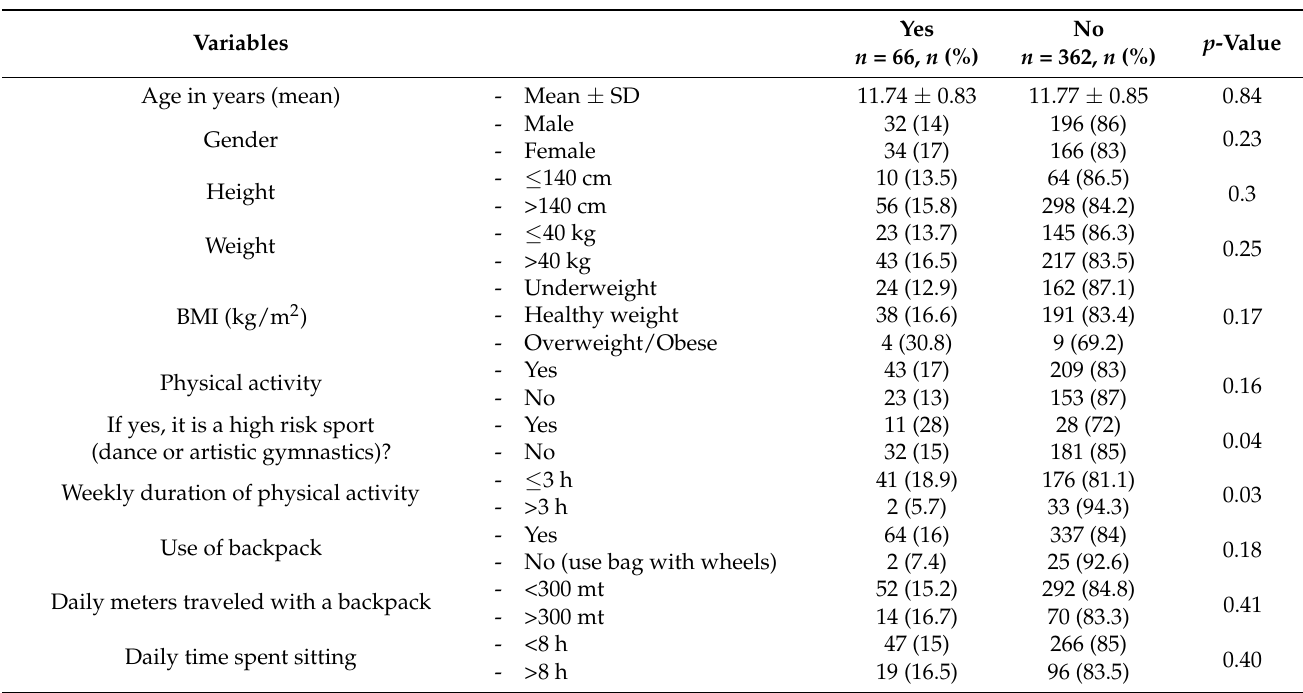
Table 1. Sociodemographic characteristics and daily personal habits of pre-adolescents enrolled in the first-grade secondary schools of the Palermo district of the study sample and association in the univariate analysis to suspected adolescent idiopathic scoliosis ( n = 428).